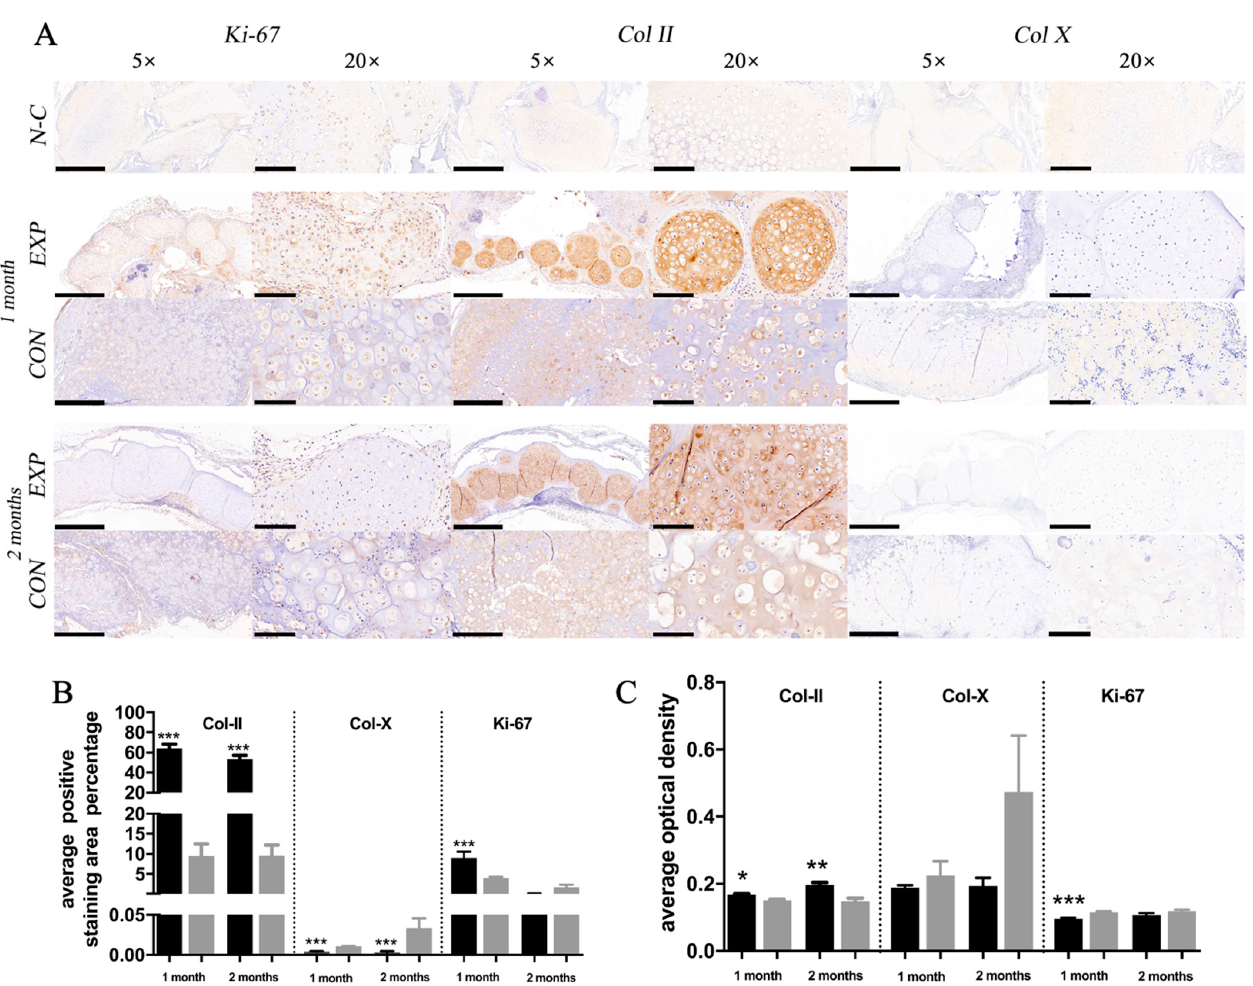
Figure 6. The immunohistochemical staining outcome including Ki-67, Col II, and Col X of natural cartilage (N-C), the EXP group and the CON group, after 1 and 2 months of implantation, under the microscope with a magnification of 5× (scale bar = 500 µm) and 20× (scale bar = 100 µm) ( A ). The AOD ( B ) and APSAP ( C ) evaluation outcomes of the immunohistochemical staining including Col-II, Col-X, and Ki-67 in the EXP and CON groups (* p < 0.05, ** p < 0.01, *** p <